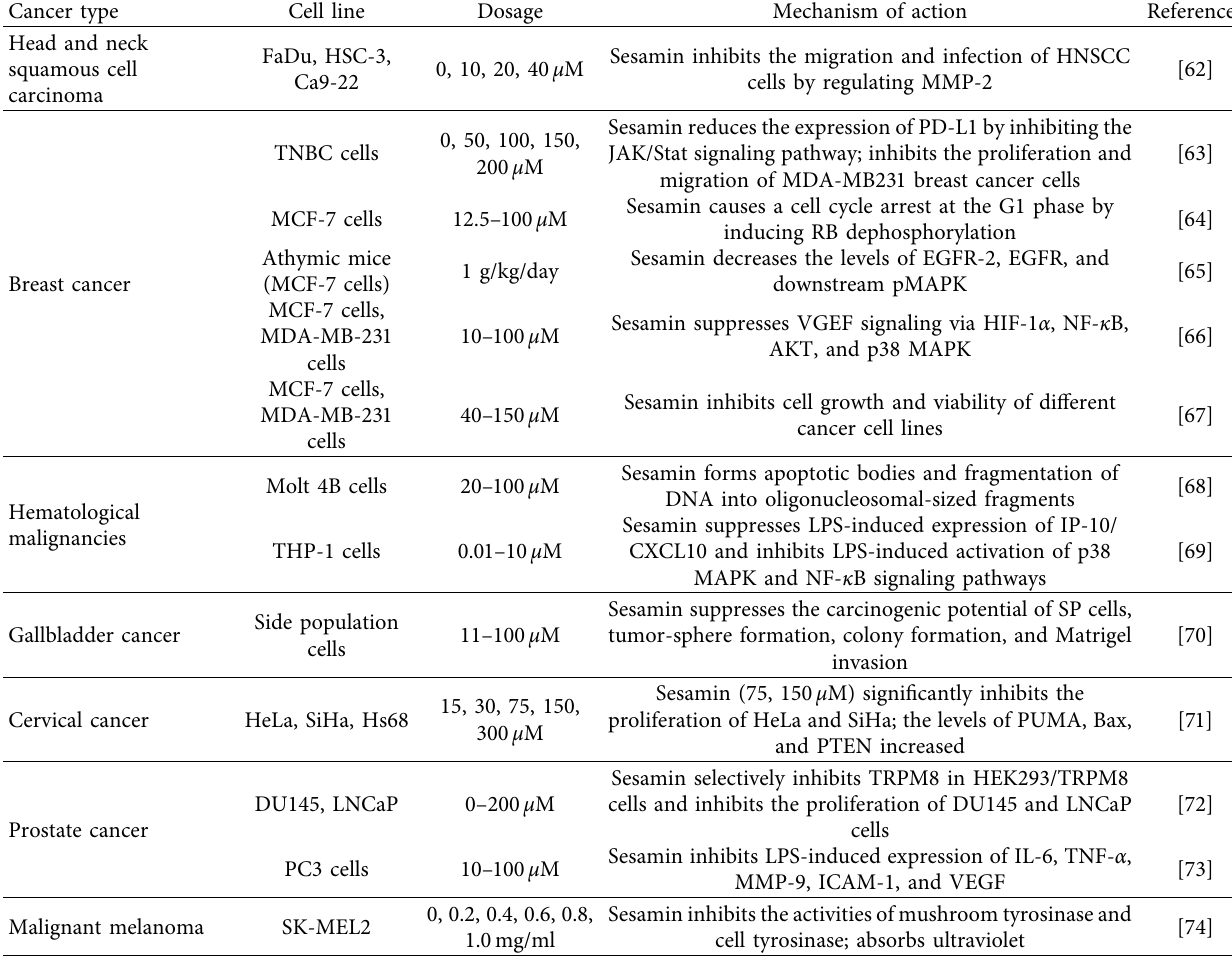
Table 3: Anticancer effects of